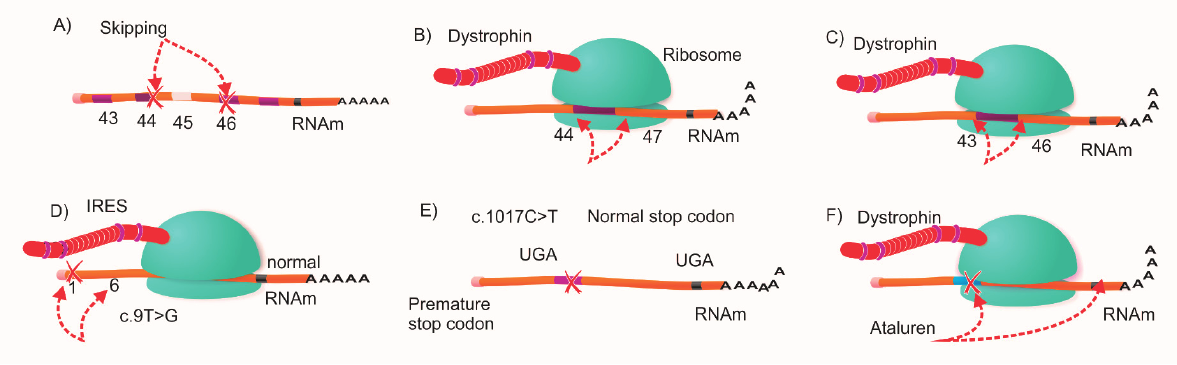
Figure 1. Molecular therapeutic strategies to restore dystrophin expression in Duchenne Muscular Dystrophy (DMD) patients. Reading frame restoration could be achieved in different combinations; ( A ) for an exon 45 deletion, the reading frame could be restored by targeted skipping of exons 44 or 46; while ( B ) and ( C ) show other in-frame combinations that allow the production of shorter dystrophins; ( D ) the IRES-induced translation mechanism; alternative initiation codon in exon 6 rescues dystrophin production ( E ) and ( F ) show the ribosomal read-through of a premature stop codon by the therapeutic agent